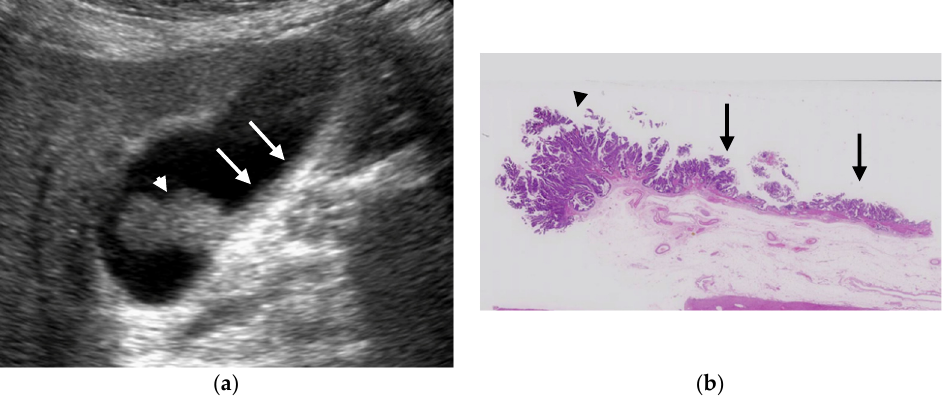
Figure 9. Localized slight thickening of an inner hypoechoic layer around GPL. ( a ) HRUS delineated a localized slight thickening of an inner hypoechoic layer (arrow) around a sessile GBC (arrowhead). ( b ) Histopathologically, this finding corresponded to the laterally spreading of carcinoma (arrow). Reprinted with permission from ref. [7]. Copyright 2021 Japan Society of Ultrasonics in Medicine.